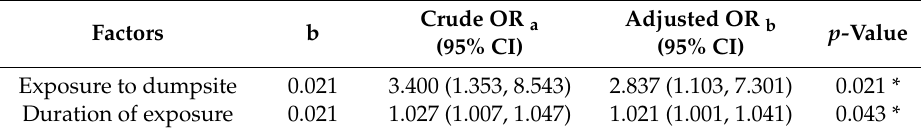
Table 5. The association between dumpsite exposure and diabetes mellitus.